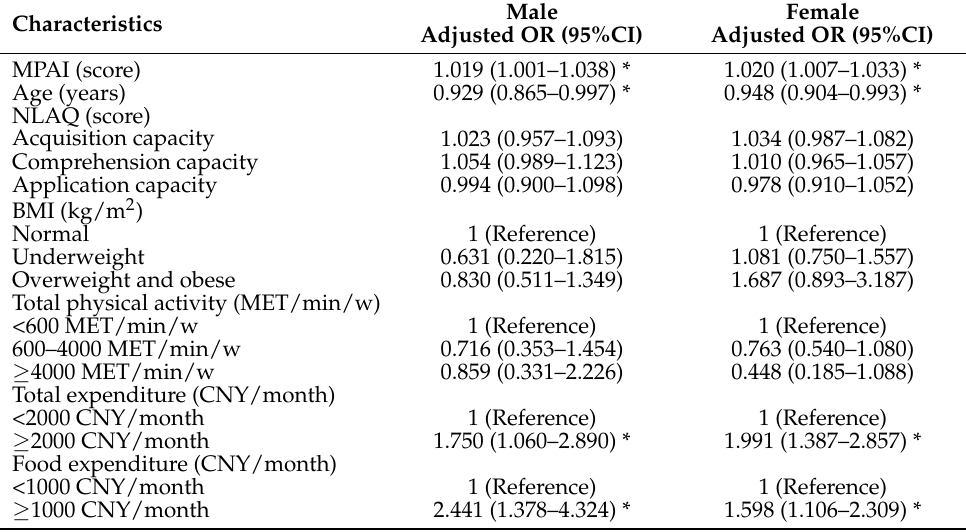
Table 3. Multivariate logistic model to explore MPAI and other potential factors that may influence other sugar-based beverages intake stratified by sex.